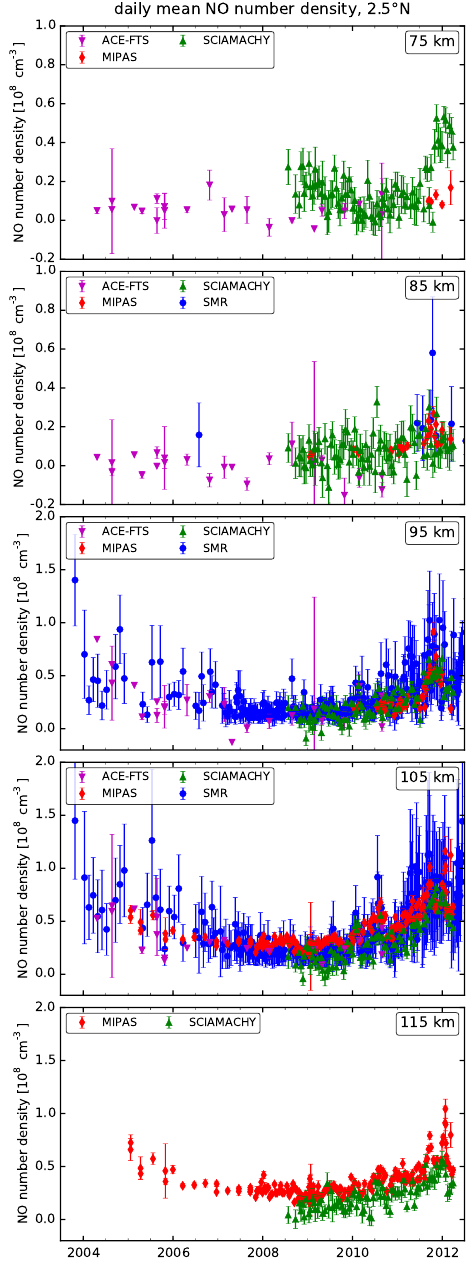
Figure B3. NO time series comparison of all four instruments at 32.5 ◦ S, for 75km, 85km, 95km, 105km, and 115km (from top to bottom).